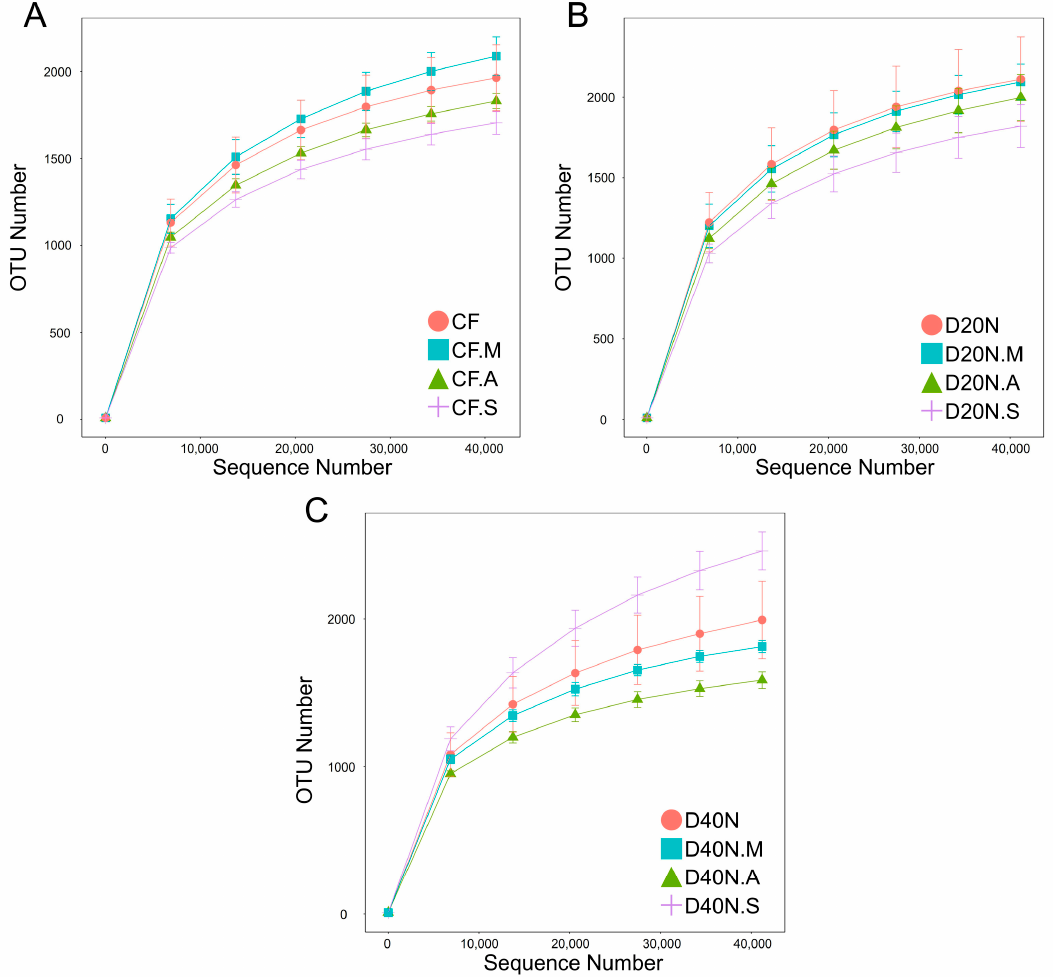
Figure 4. Rarefaction curves of bacterial communities in all treatments. ( A ) Rarefaction curve of treatments in CF group. ( B ) Rarefaction curve of treatments in D20N group. ( C ) Rarefaction curve of treatments in D40N group. CF: conventional fertilizer, D20N: decrease of 20% nitrogen, D40N: decrease of 40% nitrogen.